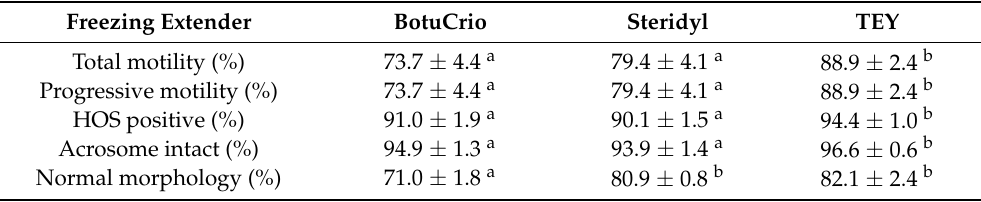
Table 2. Giraffe epididymal sperm characteristics ( n = 7) pre-freeze without cryoprotectant assessed subjectively at 37 ◦ C. Data are pooled over n = 7 males ± SEM. Columns which differ in superscript indicate significant differences between treatments ( p <